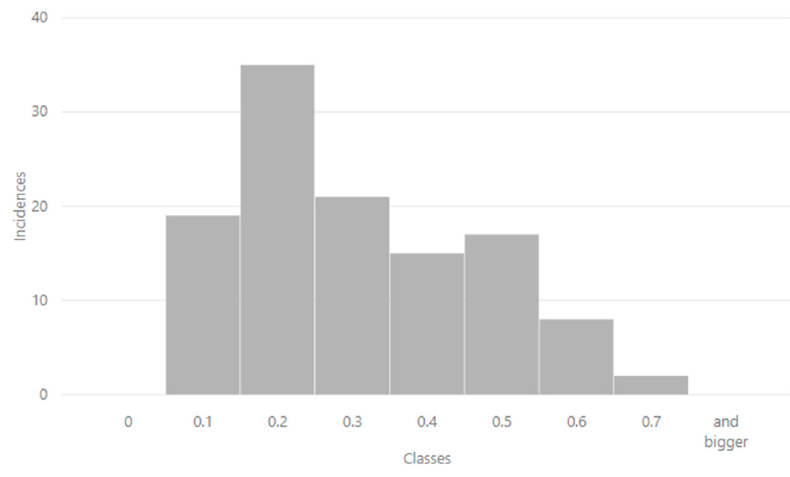
Figure 2. Distribution of 𝑅 (cid:2870) . Source: Own representation.